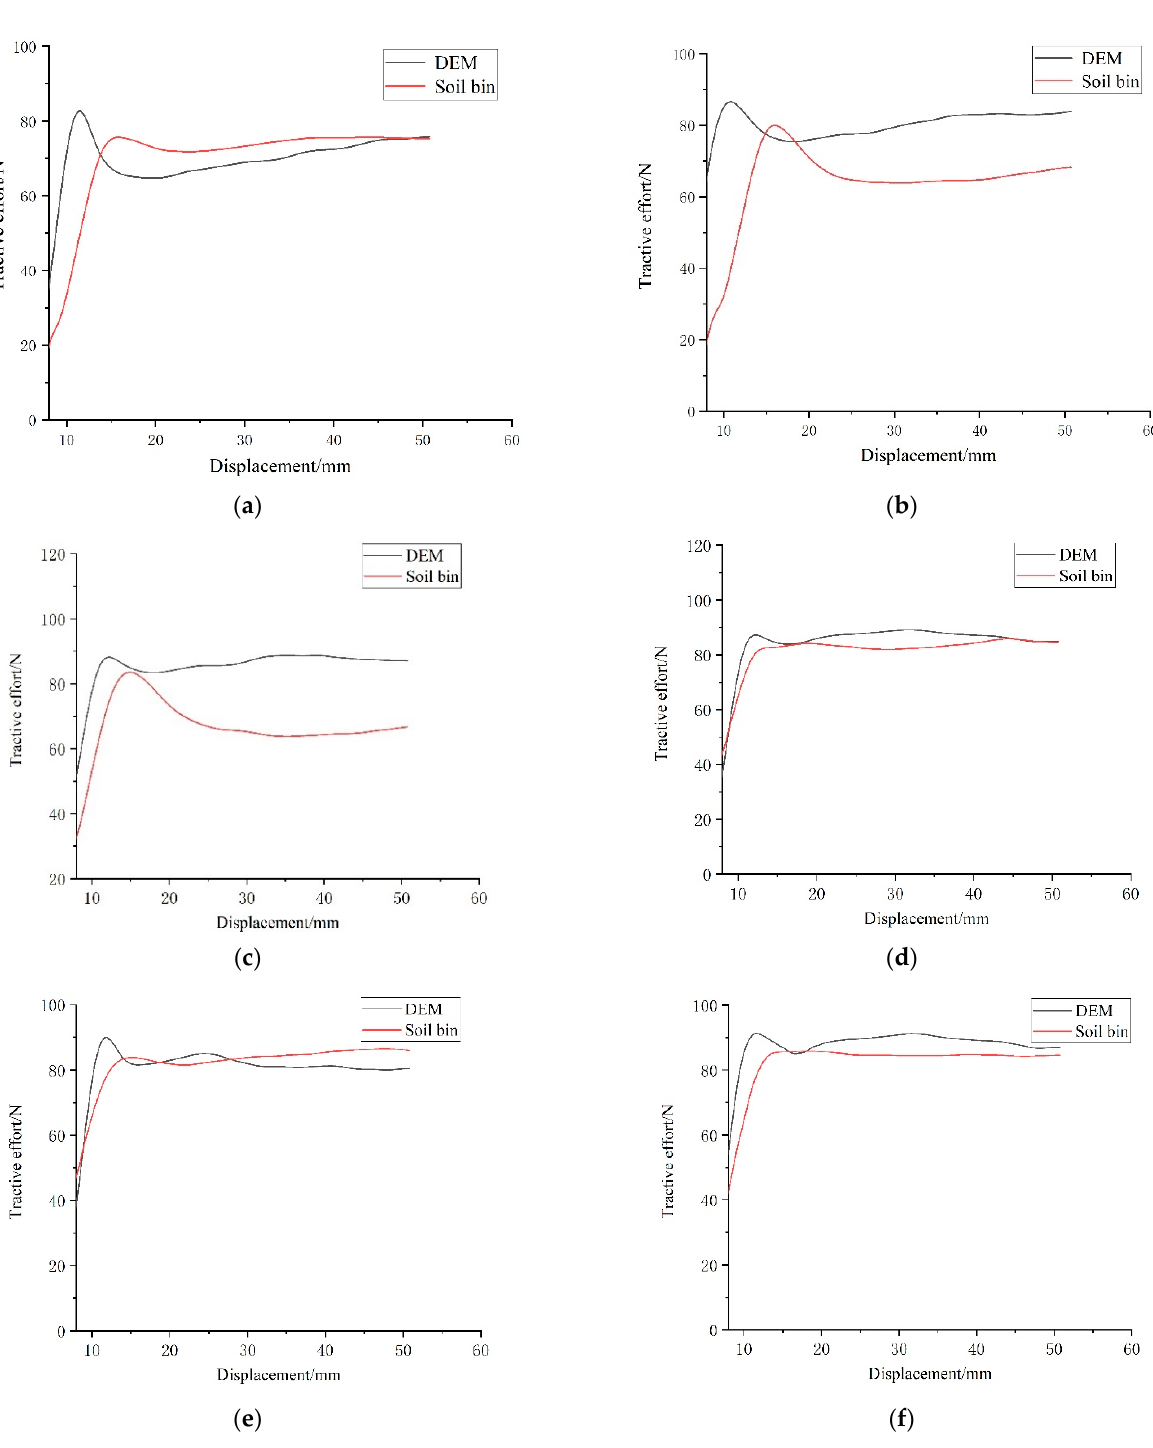
Figure 16. Comparison of the tractive effort-displacement between simulation and soil bin test: ( a ) AA scheme , ( b ) AB scheme , ( c ) AC scheme , ( d ) BB scheme , ( e ) BC scheme and ( f ) CC